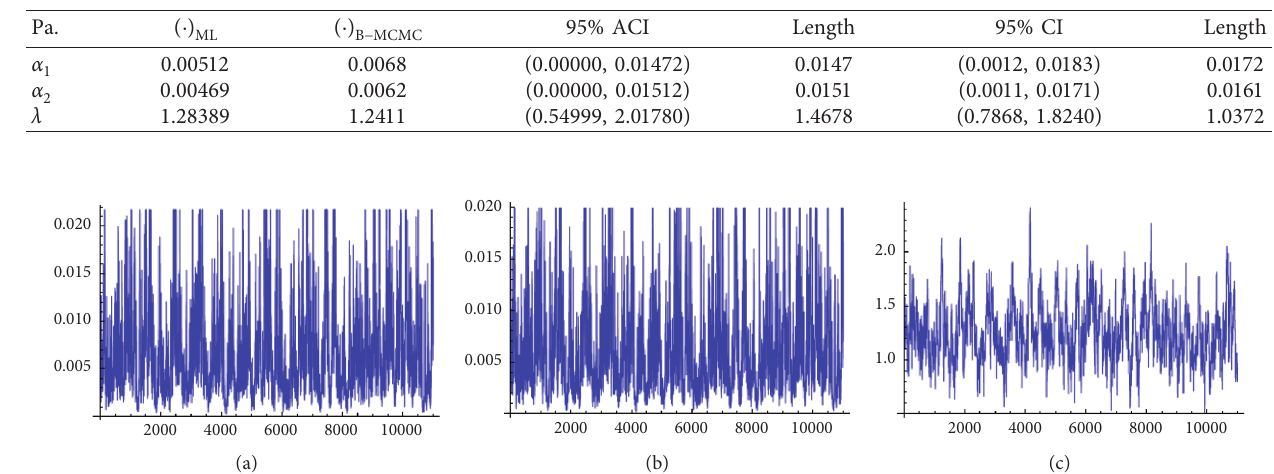
, α , and λ , respectively. 1 2